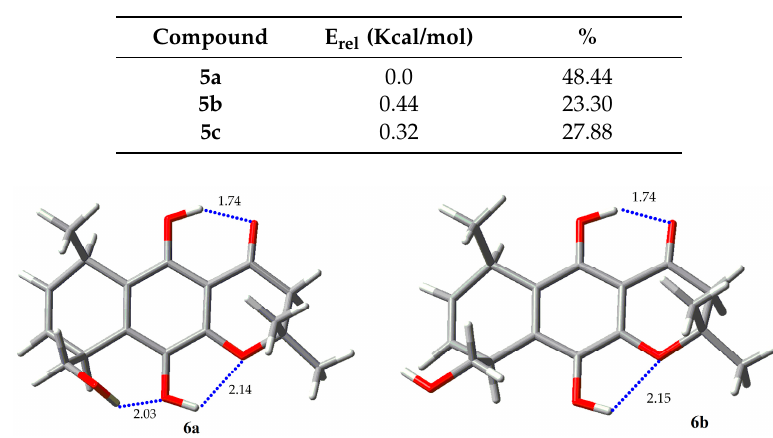
Figure 11. Rotamers for 6 . Table 8. Boltzmann population for rotamers of 6 .